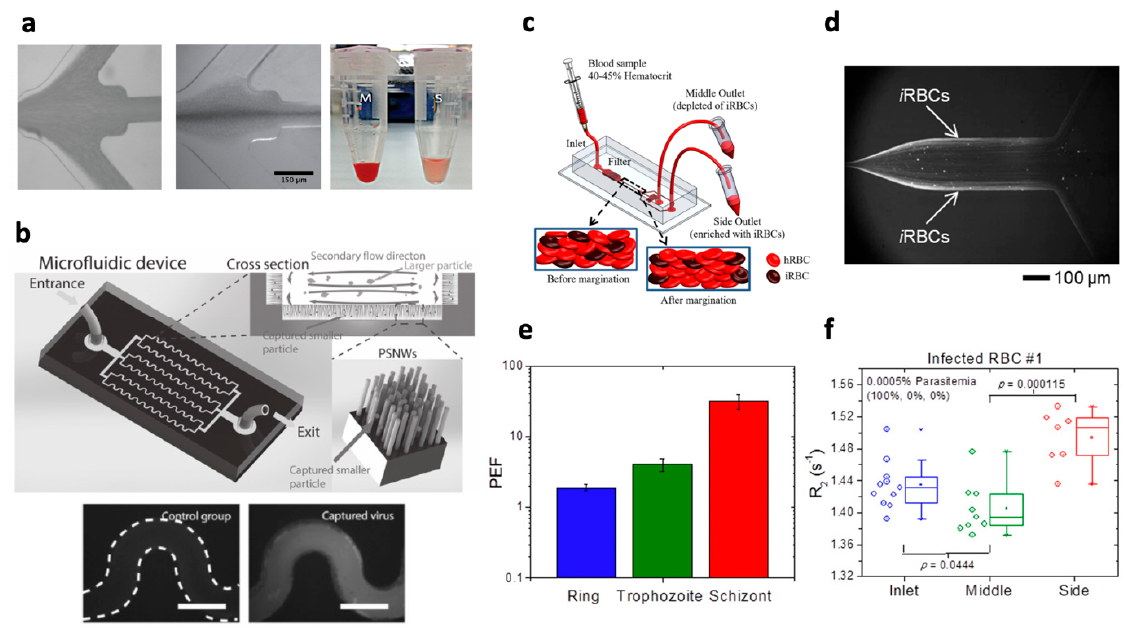
Figure 11. ( a ) The device performance for separation of RBCs without the use of Newtonian fluid (left) is compared to that with non-Newtonian fluid (center) and shows most of the RBCs exit through the center outlet only with the non-Newtonian fluid. On the right, a comparison of final samples collected in the middle outlet (M) and the side outlets (S). Adapted with permission from [176]. Copyright 2017, Springer Nature; permission conveyed through CC BY 4.0. ( b ) Symmetrically curved channels are used to create mixing to direct viruses toward the porous silicon nanowire (pSiNW) forest for capture. The control and captured channels show the comparison of no viruses and fluorescently labeled captured viruses (scale bar = 200 µ m). Adapted with permission from [185]. Copyright 2016, John Wiley and Sons. ( c ) Schematic of the microfluidic device showing the focusing of infected RBCs (iRBCS) along the channel walls, while the healthy RBCs occupy most of the center of the channel. ( d ) Image showing fluorescently labeled iRBCs along the channels’ sidewalls. ( e ) Parasite enrichment factors (PEF) for various Plasmodium developmental stages. ( f ) Comparison of MMR measurements for the R 2 relaxation rates of the inlet, middle outlet (healthy RBCs), and side outlets (iRBCs) show that the side outlets have significantly higher reading, indicating malaria infection. ( c – f ) Reprinted with permission from [188]. Copyright 2015, Springer Nature; permission conveyed through CC BY